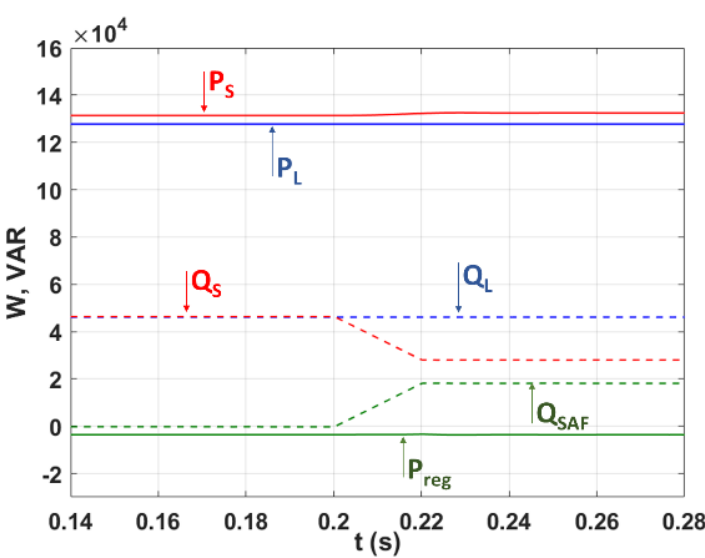
Figure 12. Energy balance of the SAF environment.